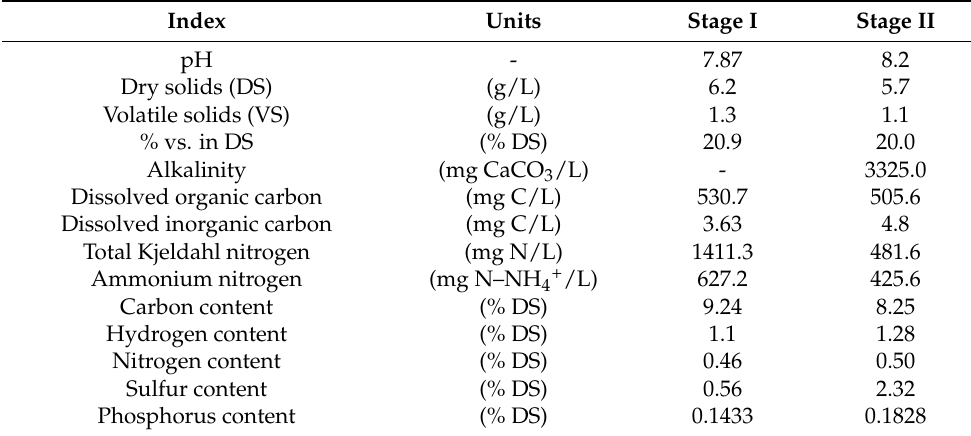
Table 1. Physicochemical parameters and elemental composition of landfill leachate, collection I (Stage I) and II (Stage II).